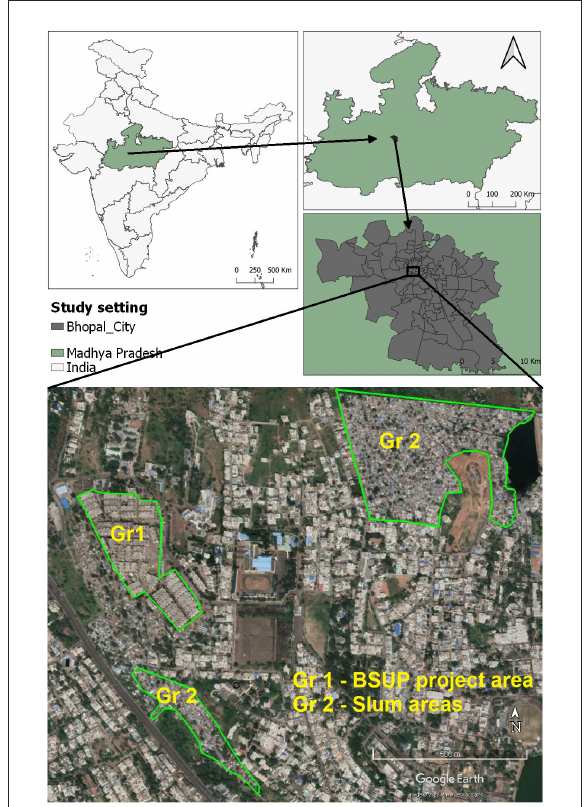
FIGURE2 Study area showing the location of Group 1 and Group 2 settings (Note: The image was created by researchers using QGIS Version 3.20, and the open-access image downloaded from Google Earth https://earth.google.com/web/ was used for illustrative